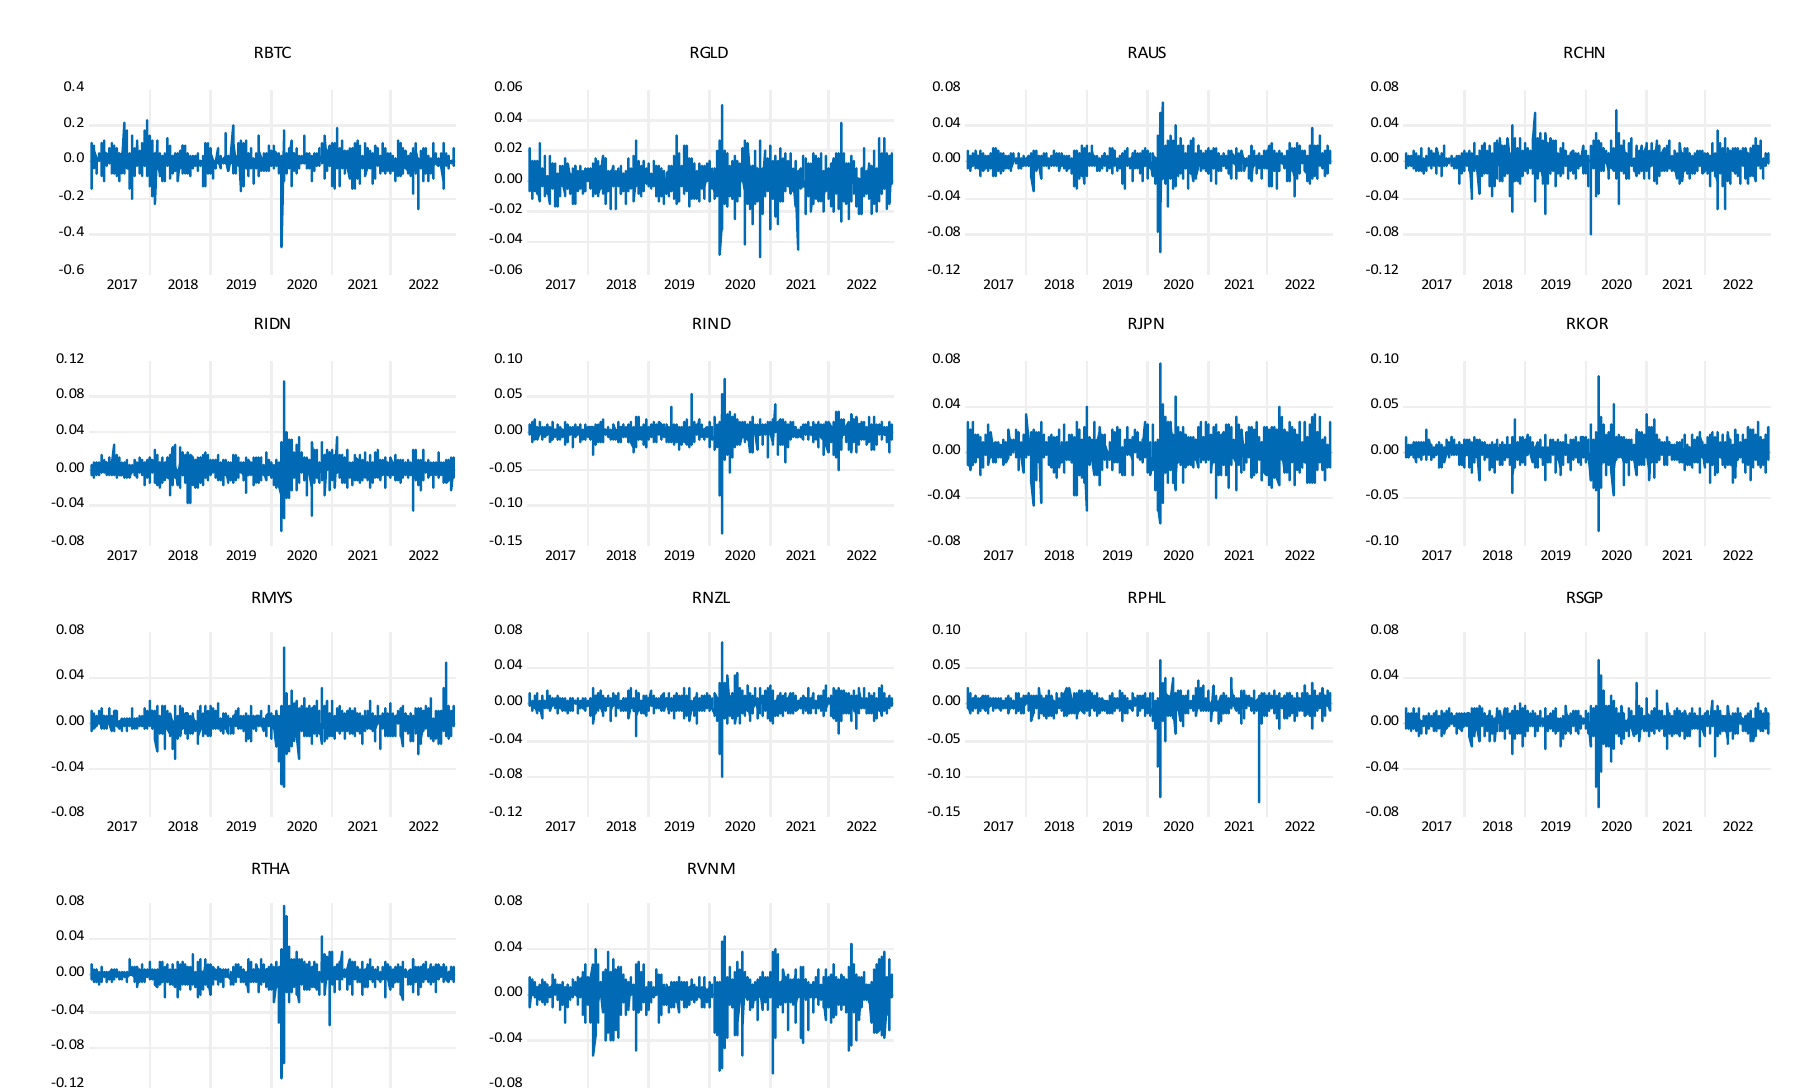
Figure 3. Returns of Bitcoin, gold, and ASEAN+6 stock indices.